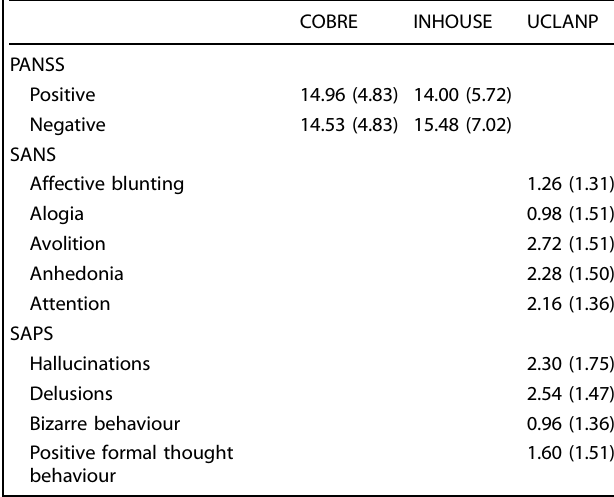
Fig. 1 Mass-univariate exploratory analysis ( P uncorr. <0.001) of INT within and between SZ and HC of the COBRE dataset. In the top left and right, we observe the expected pattern of increased INT in frontal and parietal areas in both groups. The lower left panel depicts the areas that show longer INT in HC compared to SZ, namely: the right postcentral gyrus, the right occipital fusiform gyrus and the right cuneal cortex, the left occipital pole and the left lateral occipital cortex. The lower right panel depicts the areas that show longer INT in SZ compared to HC, namely the left supramarginal and middle frontal gyrus. Table 1. Mean and standard deviations of symptom severity in all three patient